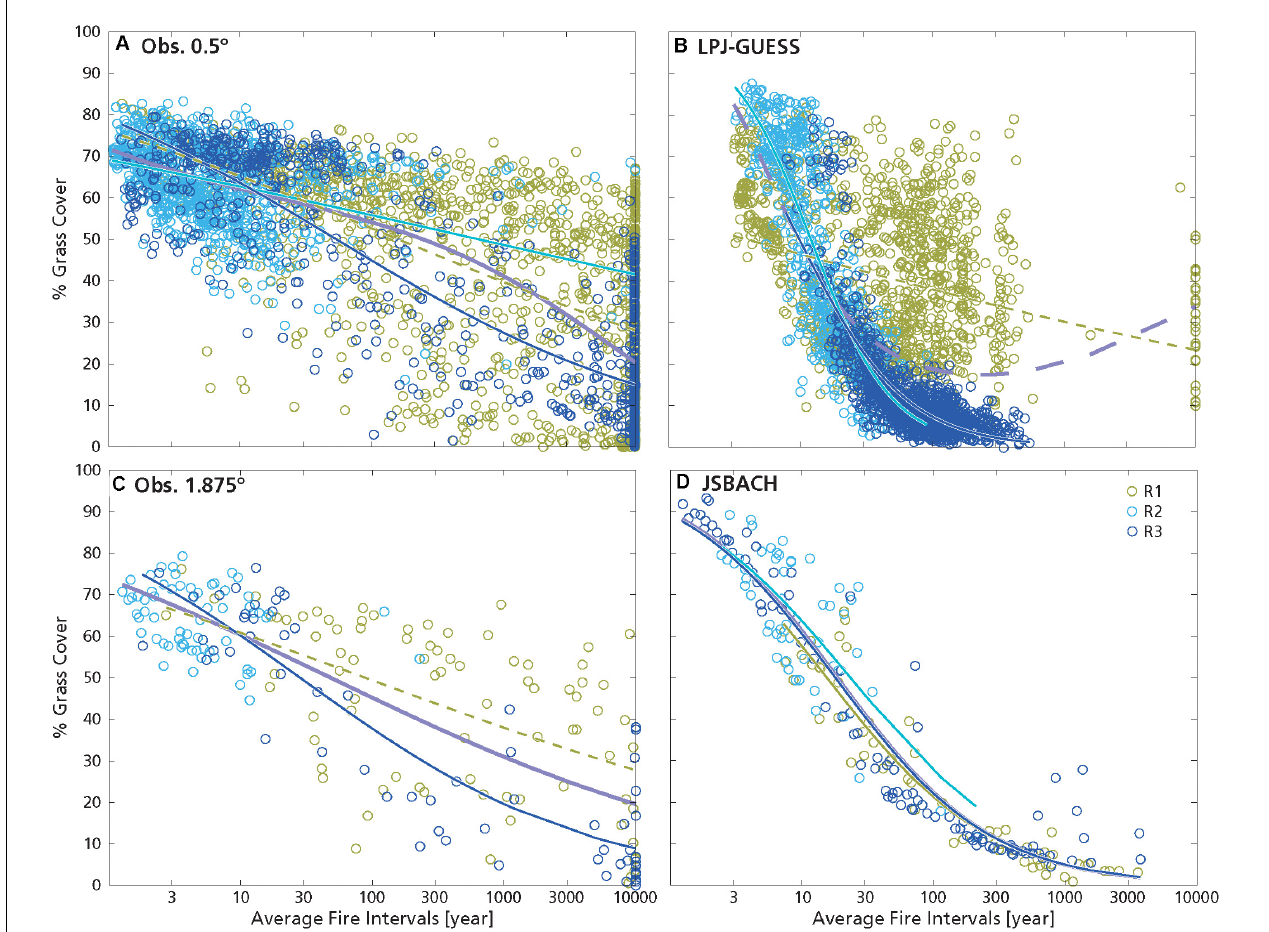
FIGURE 2 | Grass cover as a function of average fire intervals (in logarithmic scale): (A) obs. 0.5 ◦ , (B) LPJ-GUESS, (C) obs. 1.875 ◦ , and (D) JSBACH. Green circles: grid cells in R1 (MAR ≤ 590 mm year − 1 ); Light blue circles: grid cells in R2 (590 mm year − 1 < MAR < 1200 mm year − 1 ); blue circles: grid cell in R3 (MAR ≥ 1200 mm year − 1 ). Lines are the GLM fits of grass cover with log 10 (AFI) within the three MAR ranges (with the same colors as the circles) and over all data (lilac line). Only significant fits are shown. Lines are continuous when the fits are the best GLMs explaining grass cover variation (i.e., with minimum AIC, Table 2